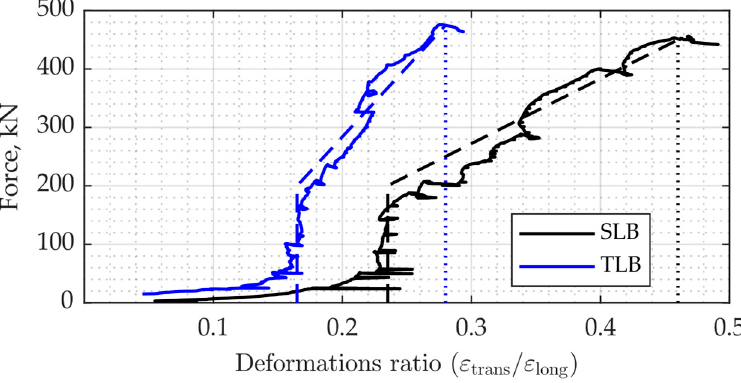
ε trans / ε long ) vs.